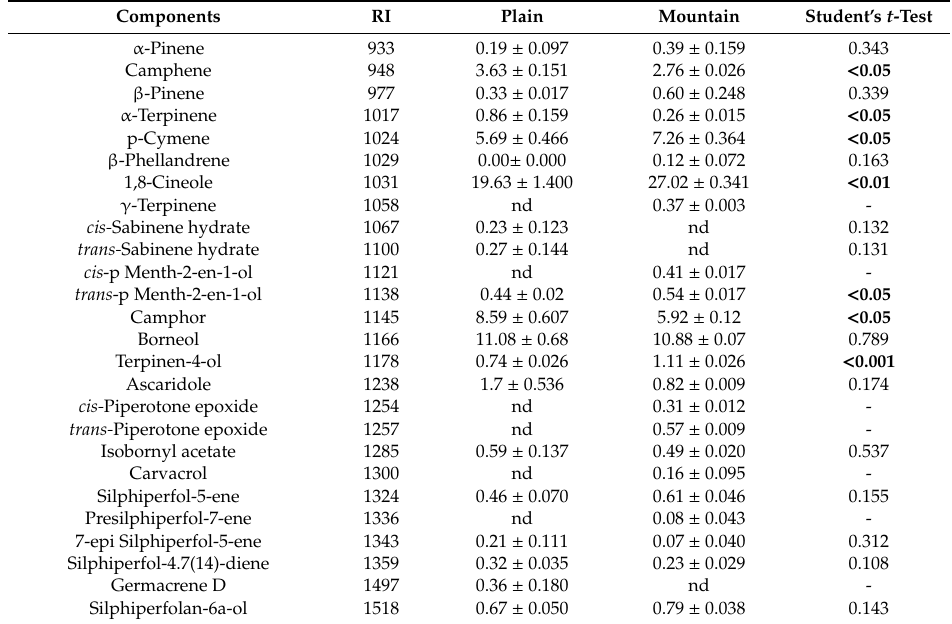
Table 3. Chemical composition (%) of essential oils of artemisia plants grown at di ff erent altitudes (plain vs. mountain). Data are expressed as means ± SE (n = 3), and significant di ff erences ( p < 0.05, p < 0.01, p < 0.001) in bold between treatments are indicated by Student’s t -test p